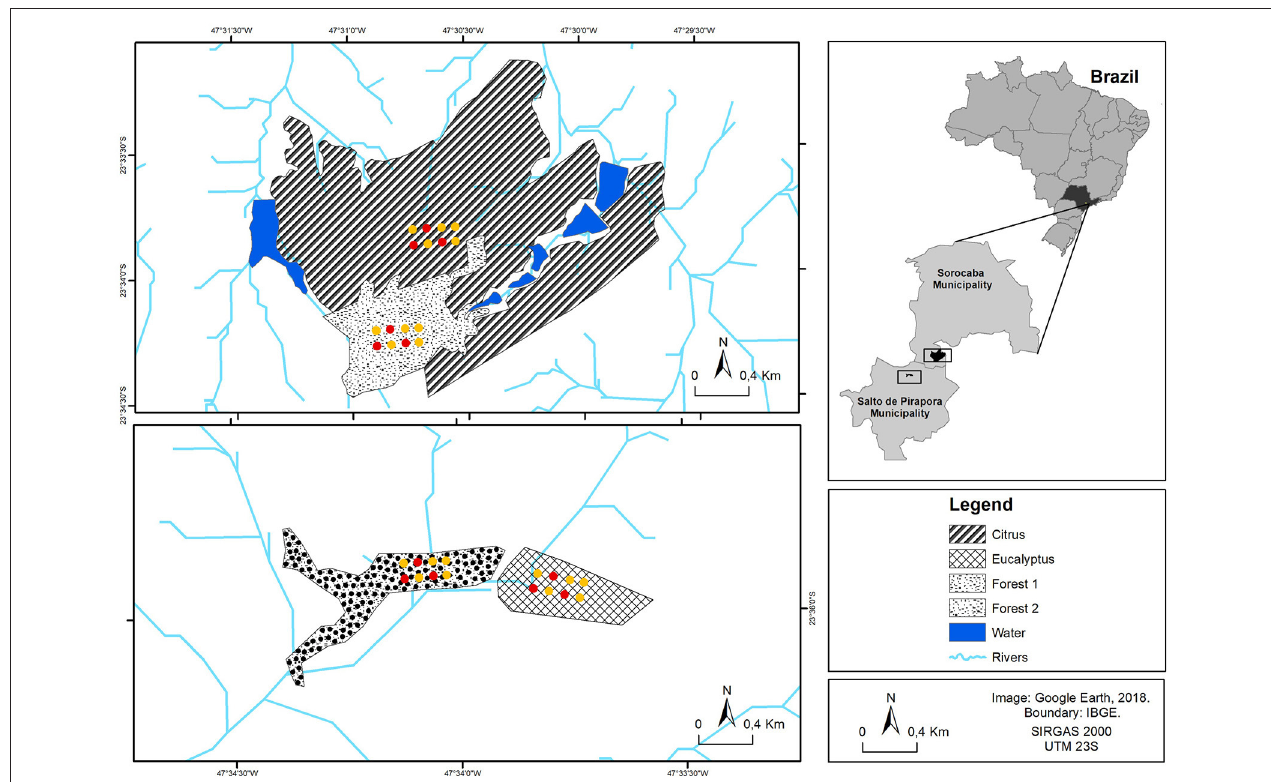
FIGURE 1 | Sampling site locations for Citrus, Forest 1, Eucalyptus and Forest 2. The chambers for gas sample collection (red and yellow points in the diagram) were installed at each sampling site in dry and wet seasons. Soil and plant residue samples (also the yellow points in the diagram—soil and plant residue sampling cores were randomly chosen next to the yellow point chambers) were taken at each sampling site (for a total of five samples per sampling site at each